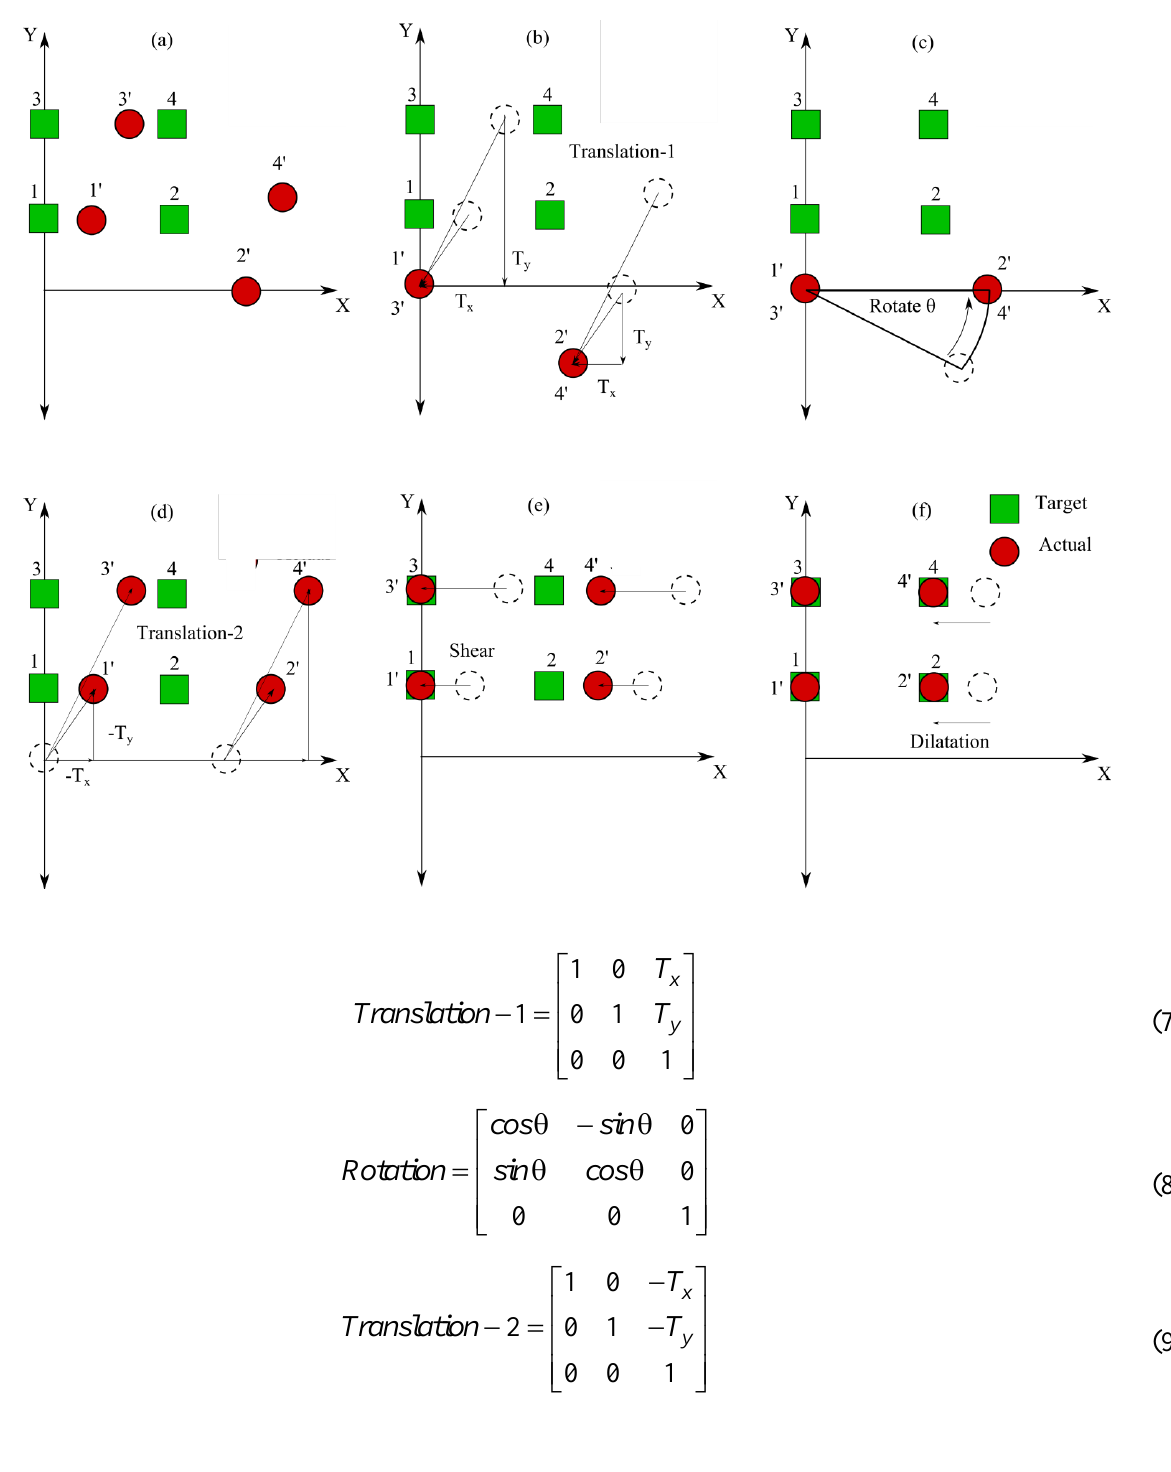
Figure 8. Geometry processes to build the eye gaze motion tracking system using the EOG. ( a ) Actual positions compared to the targets. ( b ) Translation of the reference pixel to the center of the coordinate (Translation-1). ( c ) Rotation of the actual pixel to the center of the coordinate. ( d ) Translation with opposite scale factor from the translation in (Translation-2). (b). ( e ) Shear. ( f )